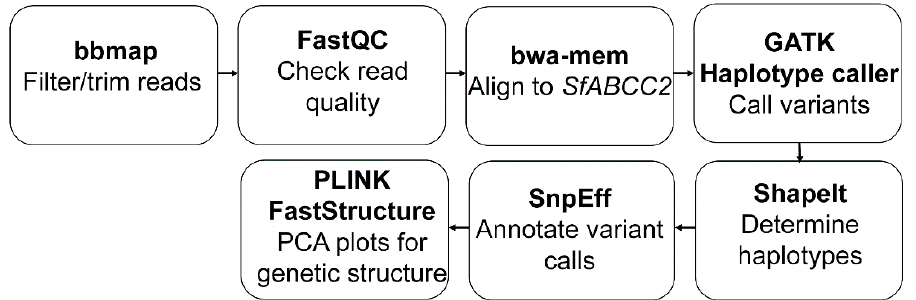
Figure 1. Schematic pipeline of overall workflow used in this work from raw Fastq targeted sequenc- ing reads to population genetics and phylogenetic analyses based on bi-allelic SNP variant